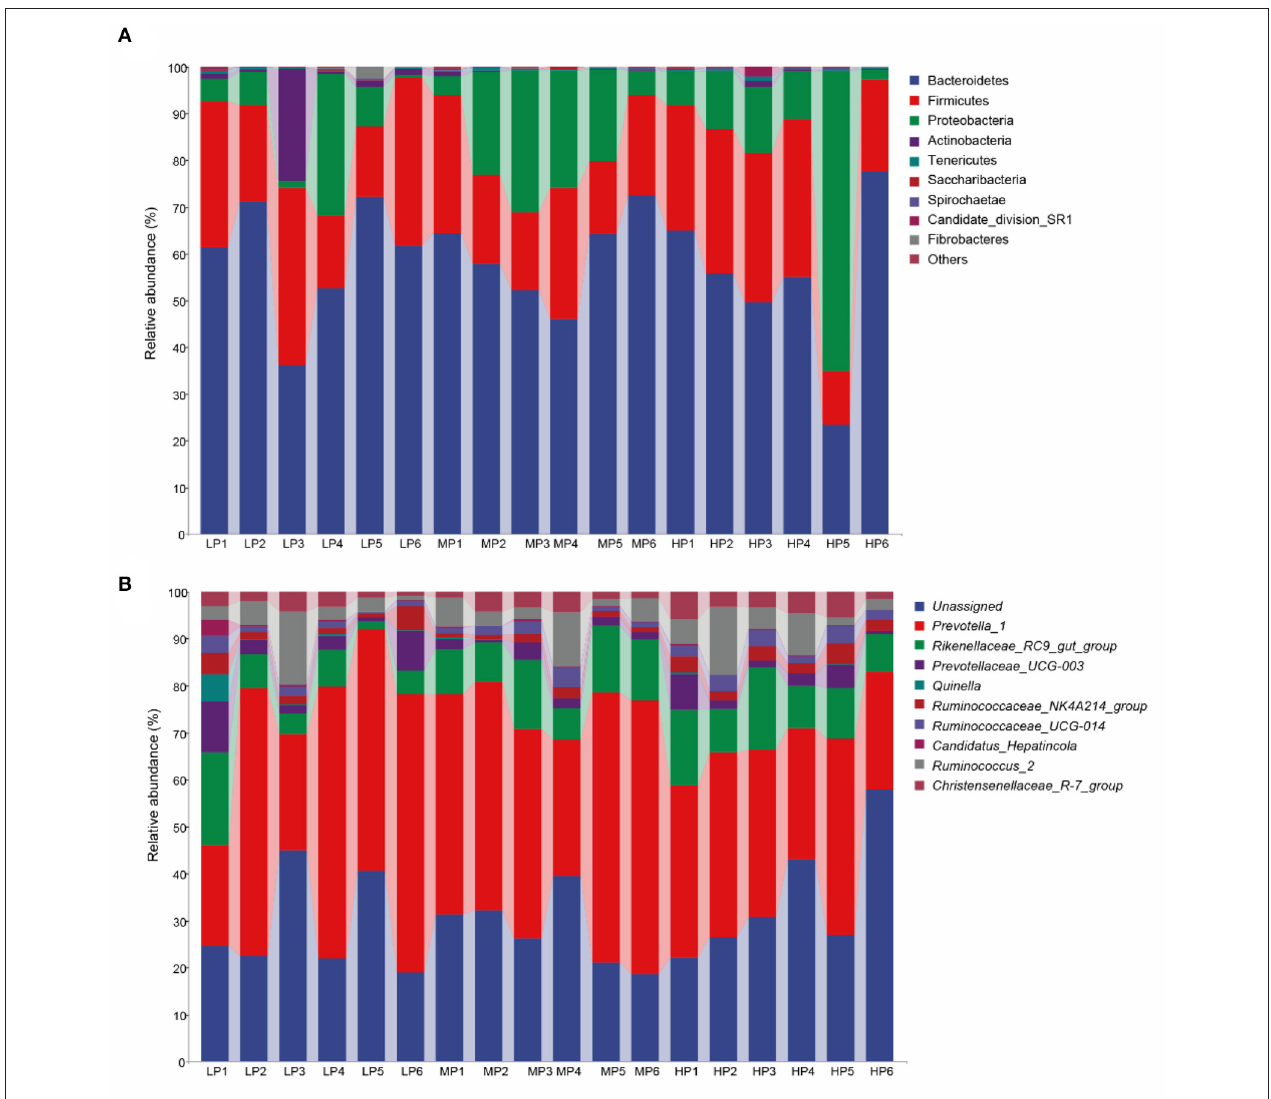
FIGURE 2 | Microbial composition of rumen fluid samples at the (A) phylum and (B) genus level.